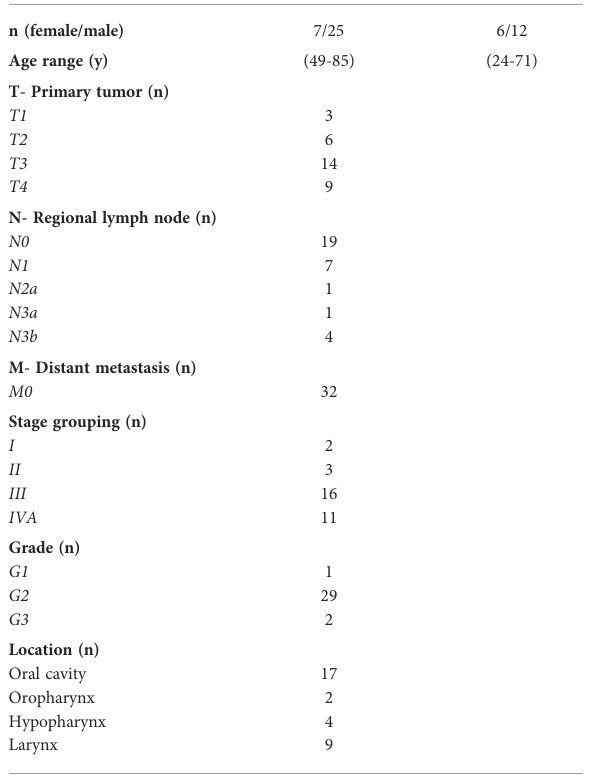
TABLE 1 Clinicopathological characteristics of HNSCC patients and